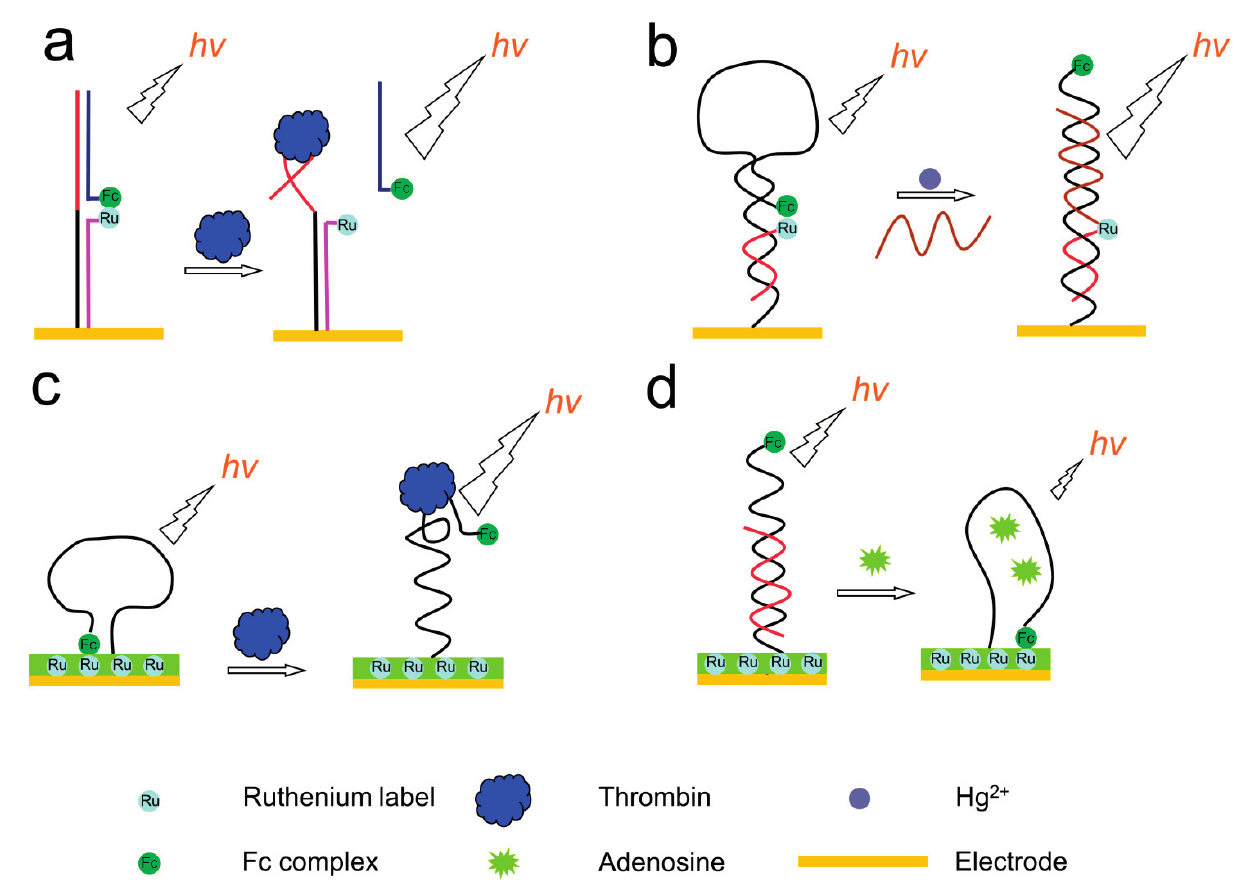
Figure 20. ECL sensing platforms based on the quenching of Ru(bpy) 32+ ECL by ferrocene. ( a ) adapted with permission from ref. [212], copyright (2008) Elsevier; ( b ) adapted with permission from ref. [213], copyright (2013) Elsevier; ( c ) adapted with permission from ref. [214], copyright (2009) Elsevier; ( d ) adapted with permission from ref. [215], copyright (2010)